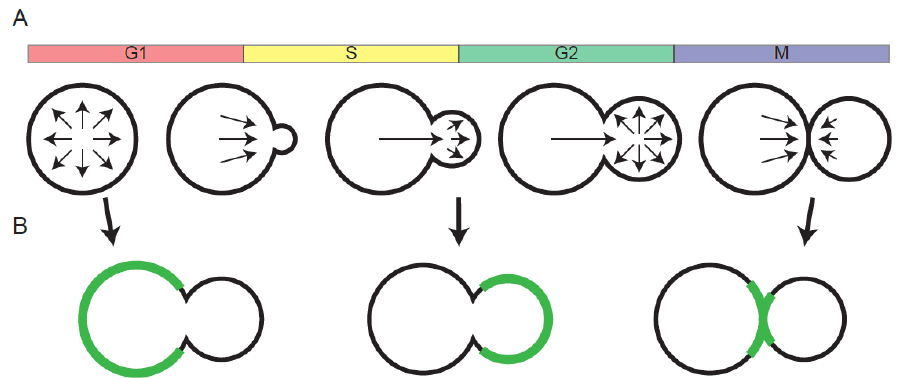
Figure 1. Stereotyped pattern of secretion enables localization dependent on the time of synthesis during the cell cycle. ( A ) Arrows indicate secretion patterns through the cell cycle. ( B ) With no di ff usion, cell wall-linked proteins are spatially distributed in a manner that reflects where they were initially secreted. This leads to their accumulation in the mother, the bud, or at sites of cytokinesis, depending on the timing of their synthesis during the cell